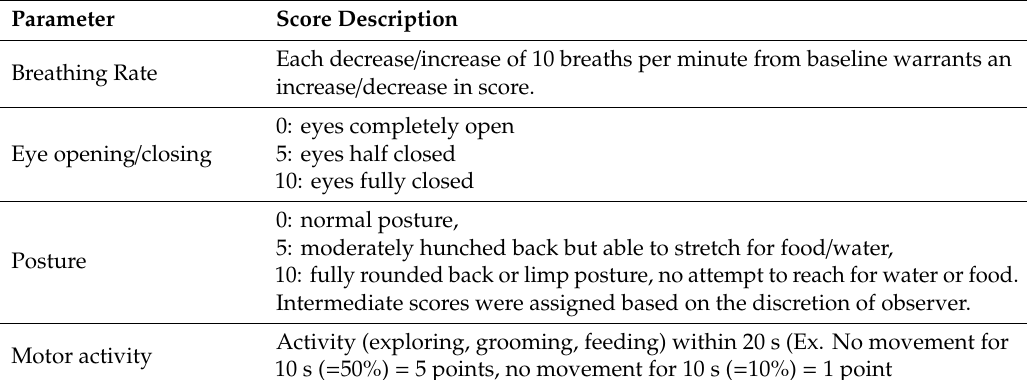
Table 1. Description of parameters used in behavior scoring system.